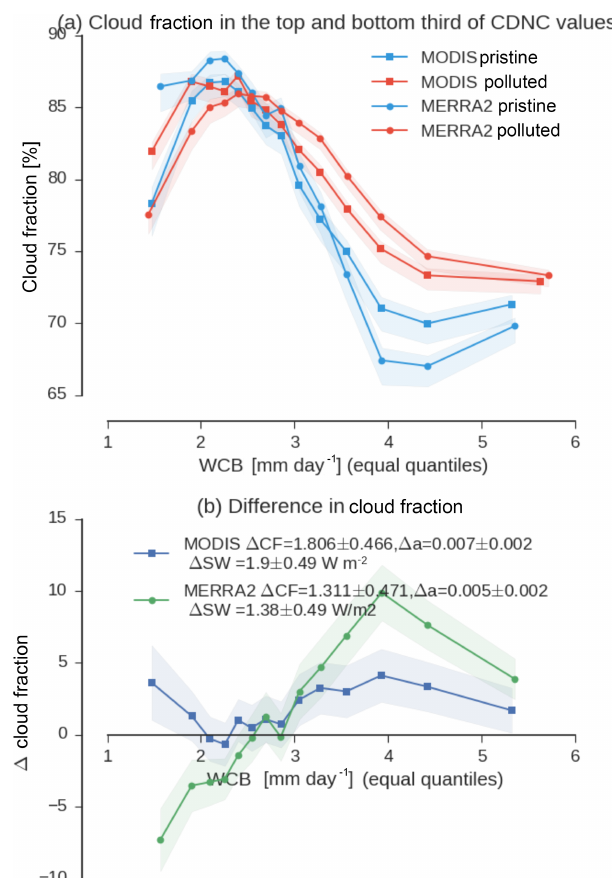
Figure 10. (a) Cyclone-mean cloud fraction split into 15 equal quantiles and split into high and low CDNC SW populations. Shaded areas show 95% confidence range in the mean in each quantile. The CDNC data set used to partition the cyclone population is noted in the legend. Panel (b) shows the difference between the high and how CDNC SW populations. The difference in cloud fraction be- tween the populations and 95% confidence in the difference are noted in the legend. The relation between cloud fraction and all-sky albedo for the midlatitudes from Bender et al. (2017) is used to ap- proximate the difference in albedo consistent with this difference in cloud cover. The difference in reflected shortwave (SW) is calcu- lated by scaling the albedo by the annual-mean insolation between 30 and 80 ◦